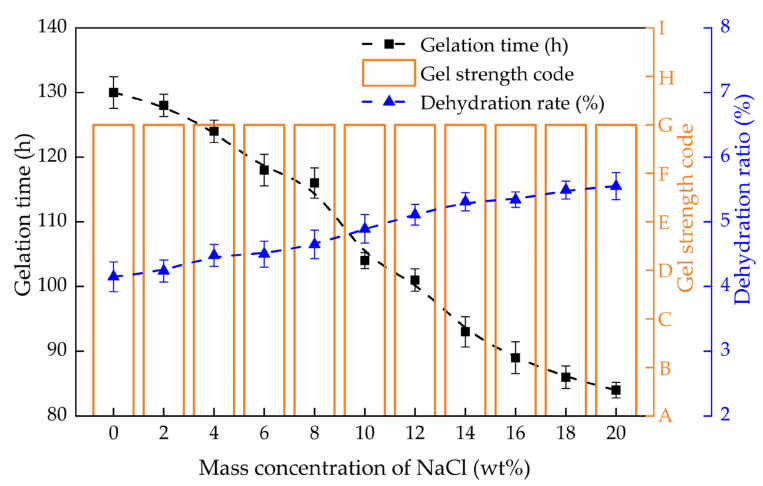
Figure 8. Gelling performance of PHRO in different concentrations of NaCl solution.